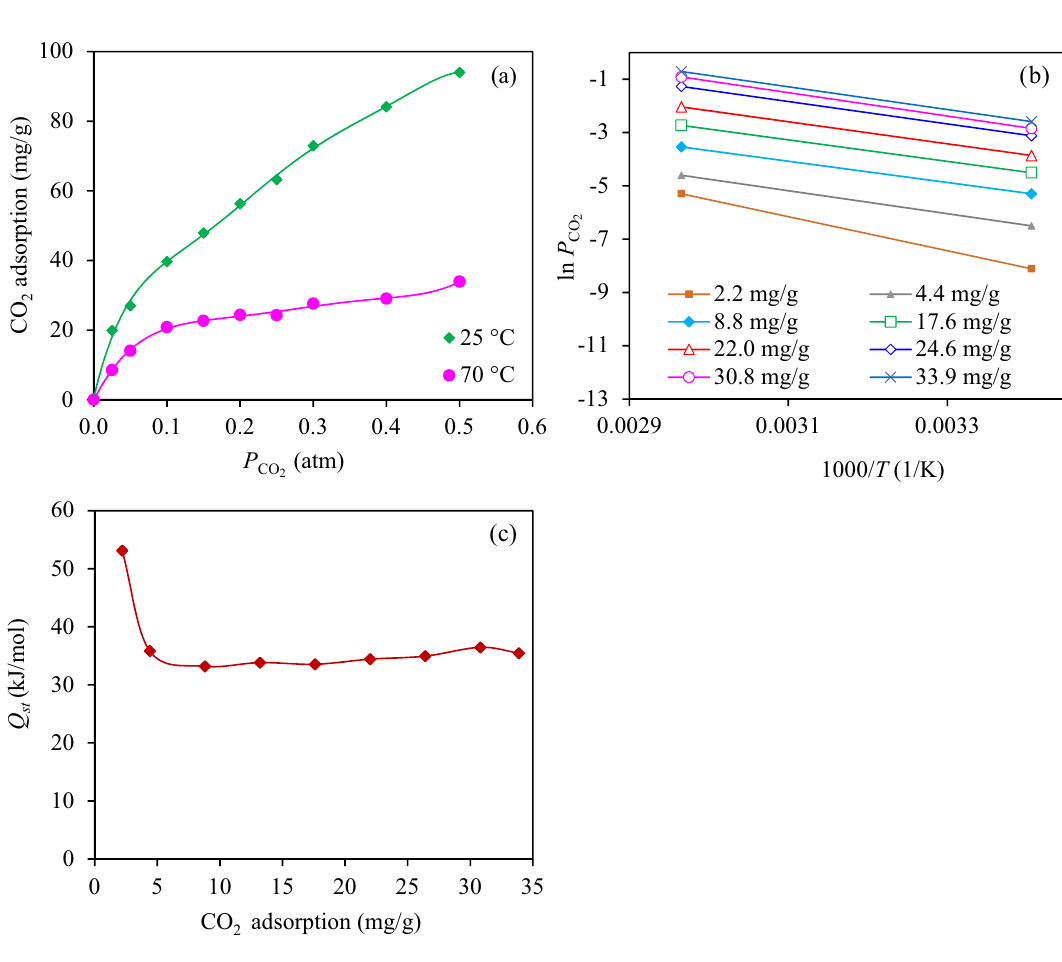
Figure 10. ( a ) CO 2 adsorption isotherm, ( b ) isosteric adsorption and ( c ) variation of isosteric heat of adsorption of 12MgO/AC at 1